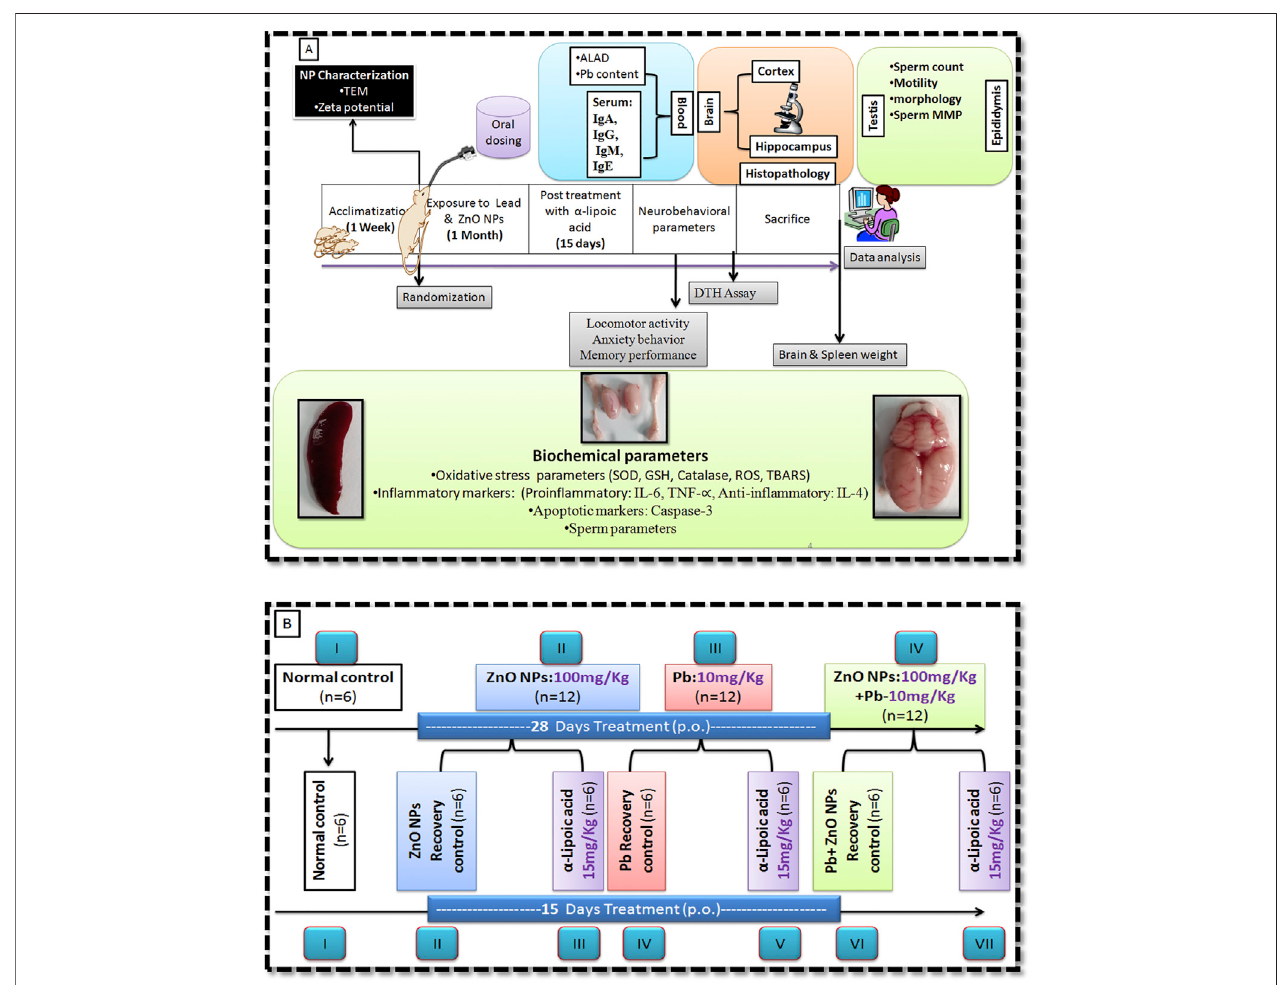
FIGURE 1 | Schematic representation of work plan. (A) Experimental design. (B) Animal groupings.